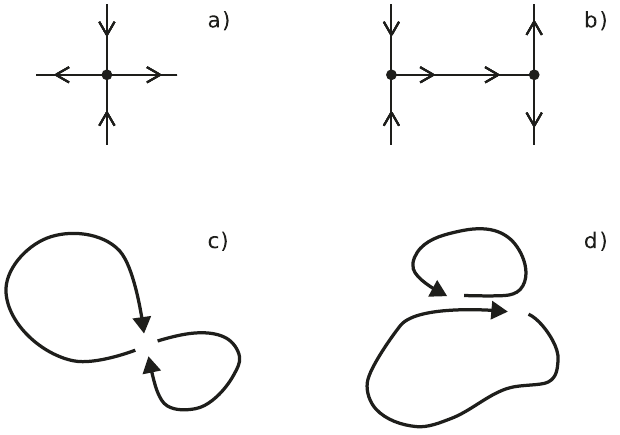
Fig. 2 Schematic representations of a hyperbolic point and a heteroclinic connection together with associated circulation patterns. Lines with converging/diverging arrows denote stable/unstable manifolds of the hyperbolic points (represented as black dots), respectively. Note that in ( b ) the manifold that realizes the connection is unstable for the left-hand side hyperbolic point and stable for the right-hand side one. Due to time- dependence, which is weak but present in geophysical fl ows, patterns like a or b are weakly perturbed and transformed in so-called moving hyperbolic points and connections. In particular, c and d sketch two examples of circulation patterns that can be often found in the ocean, respectively, associated to a hyperbolic point and to a heteroclinic connection. They exemplify two gyres sharing a common point or segment of their boundaries that can be associated to the elementary sketches ( a ) and ( b ) and are therefore expected to display high Lagrangian betweenness